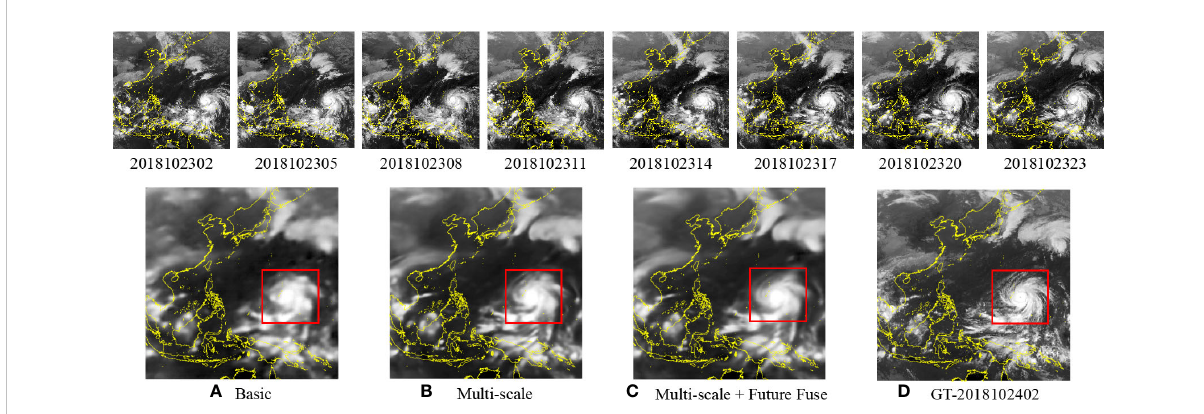
FIGURE 7 Visual results of adding multi-scale components. First-row images are the inputs. Second-row images are outputs of different networks. (A) is the basic model; (B) is the model with multi-scale spatiotemporal feature capturing; (C) is the model with both multi-scale spatiotemporal feature capturing and same-stage feature reuse; and (D) is the ground